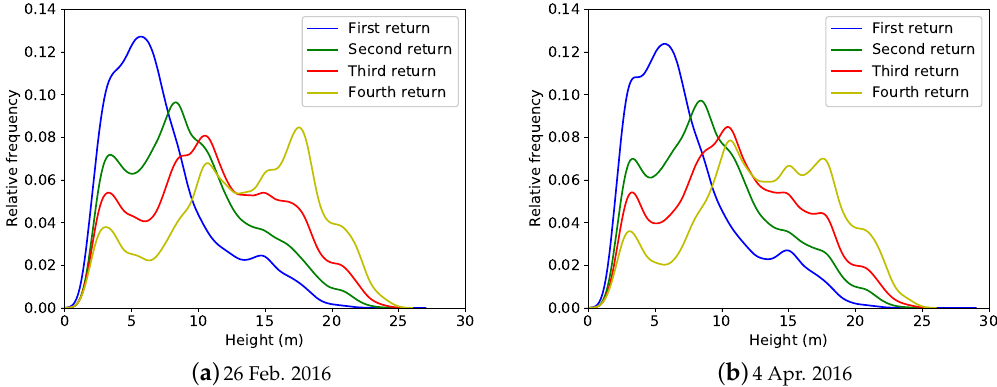
Figure A3. Comparison of the frequency distribution with Gaussian kernel density estimation of different vertical returns with height between 26 February 2016 ( a ) and 4 April 2016 ( b ) data of the control